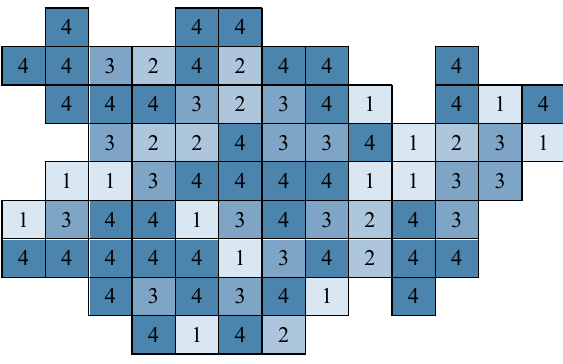
Figure 7. Optimal technological model of the coal deposit for a (78 × 4) matrix.